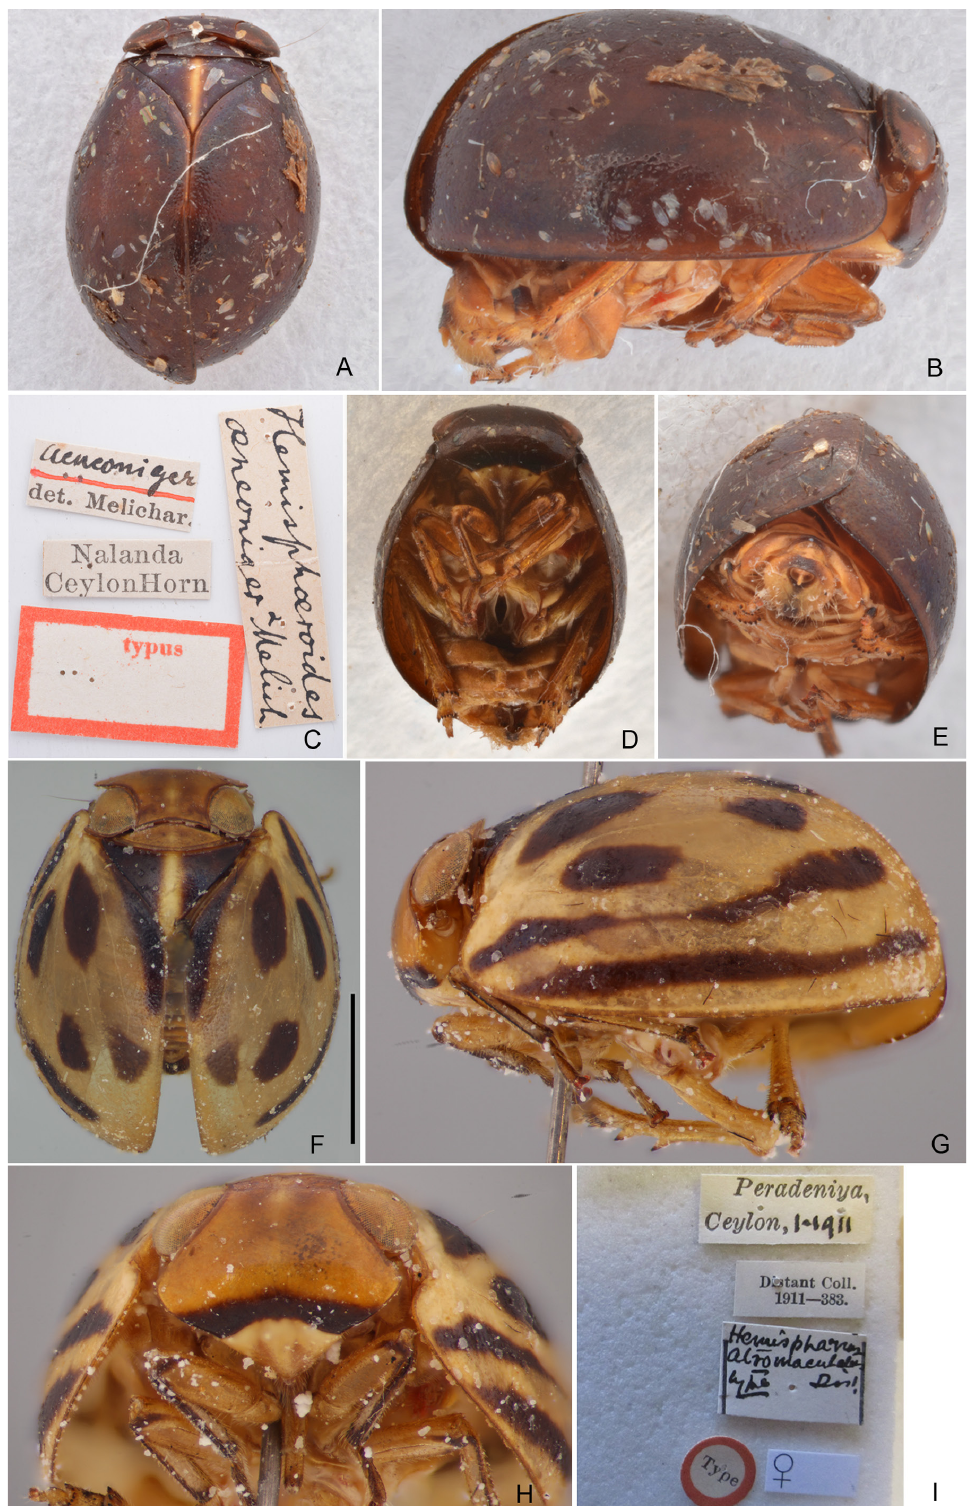
Fig. 10. Hemisphaeroides spp. A–E . Hemisphaeroides aeneoniger Melichar, 1903, syntype. A . Habitus, dorsal view. B . Habitus, lateral view. C . Labels. D . Habitus, ventral view. E . Habitus, caudal view. — F–I . Hemisphaeroides atromaculatus Distant, 1916, syntype. F . Habitus, dorsal view. G . Habitus, lateral view. H . Metope and clypeus, facial view. I . Labels. Scale bar = 1